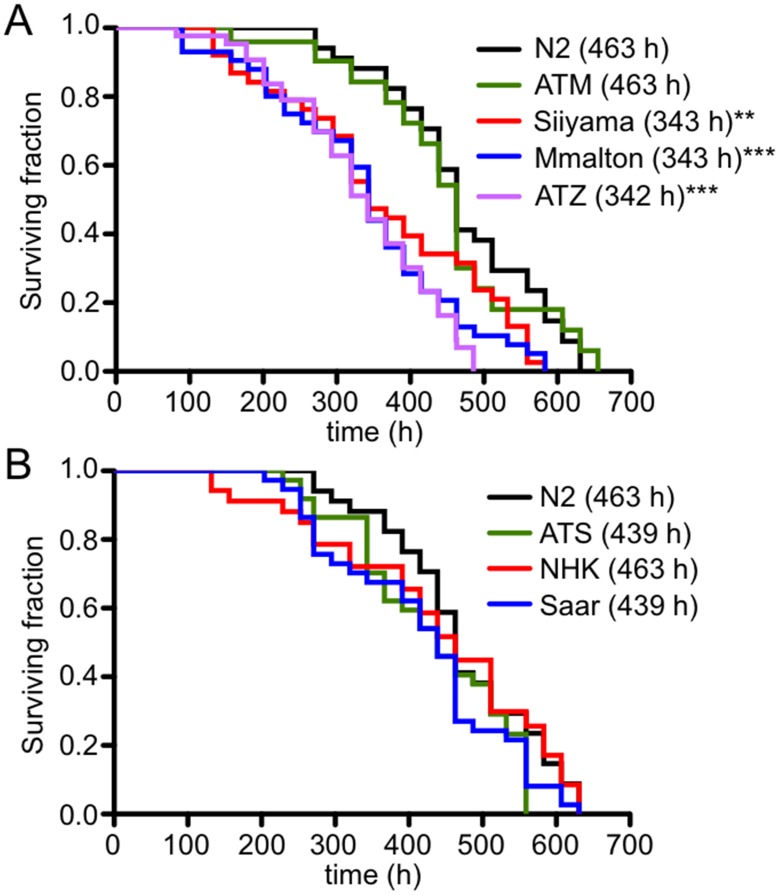
Effect of AT variant protein expression on longevity.Representative Kaplan-Meier curves of deficient mutants (A). N2 (black), ATM (green), Siiyama (red), Mmalton (blue) and ATZ (lavender). Median survival times (in parenthesis). Representative Kaplan-Meier curves of ATS and null alleles (B). N2 (black), ATS (green), NHK (red) and Saar (blue). Statistical significance determined using the Log-Rank (Mantel-Cox) test, with probabilities of results reported as **P<0.001, or ***P<0.0001.